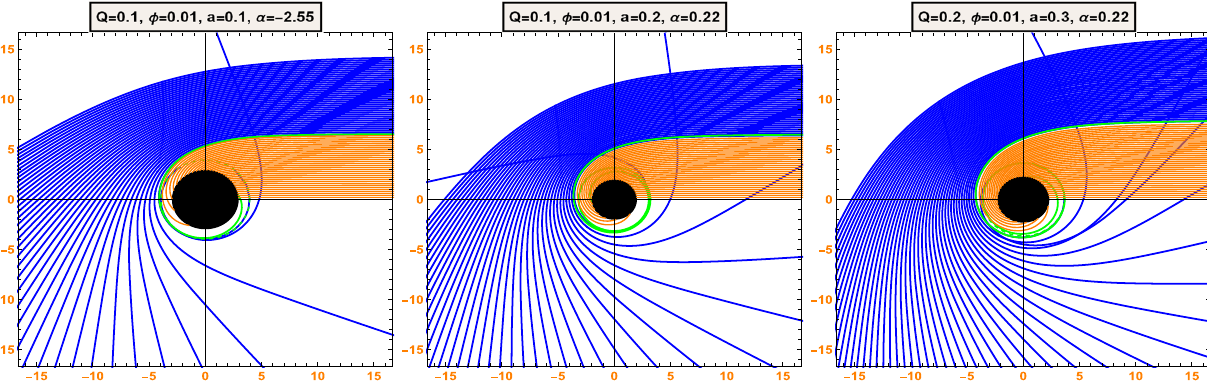
and b < b c regions, respectively. The dashed green line represents the radius of photon sphere and the mass of BH as M = 1